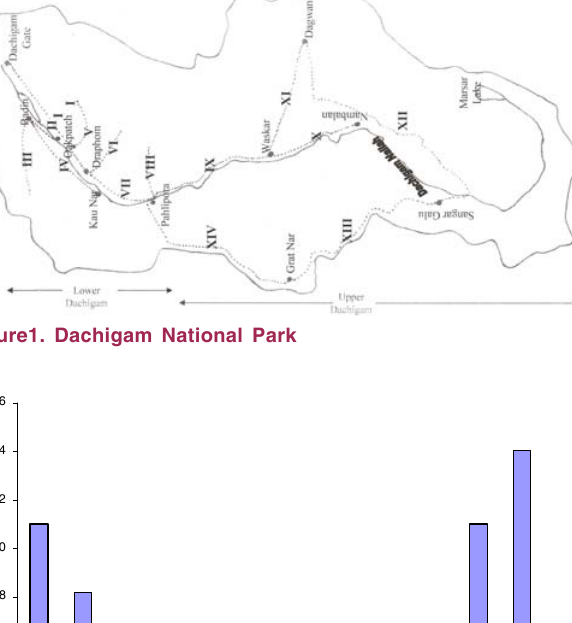
Table 1: Average numbers of deer observed during rutting